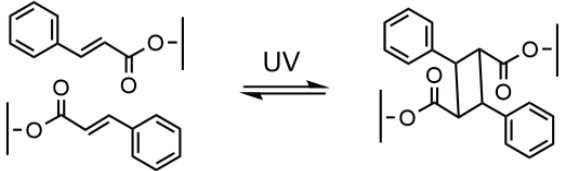
Figure 4. Cyclodimerization of cinnamoyl groups.